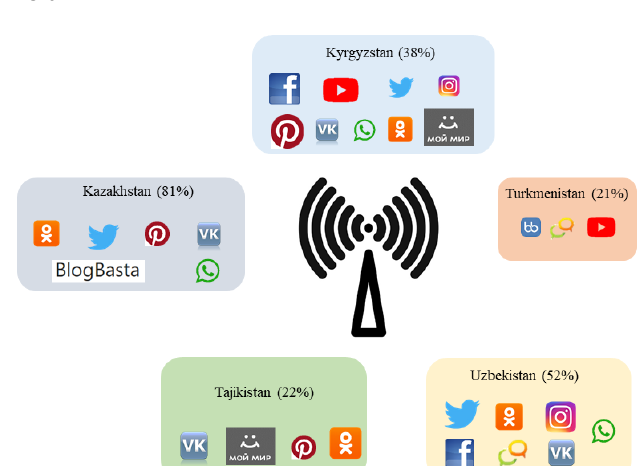
Figure 1. Popular social media platforms in Central